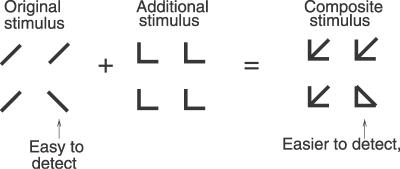
Illustration of Pomerantz's Configuration Superiority EffectThe triangle is easier to detect among the three arrow shapes in the composite stimulus, than the left-tilted bar among the right-tilted bars in the original stimulus. Identical shape of the target and distractor bars in the original stimulus could lead to confusion and longer RT.